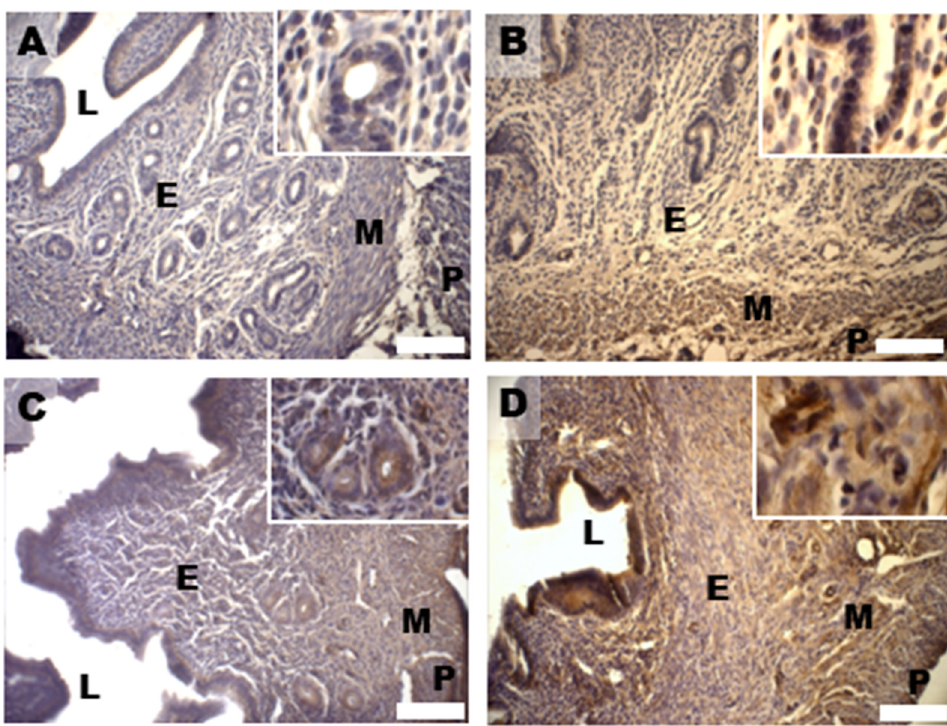
Figure 7. Immunostaining of mouse uterine horns for 4-HNE ( A – D ) of control ( A ), DHEA ( B ), DHEA/LC-ALC ( C ) and DHEA/LC-ALC-PLC ( D ) groups. Insets show details of the glandular epithelium. L: lumen; E: endometrium; M: myometrium; P: perimetrium. LM, mag. 10 × . Insets: 20 × .